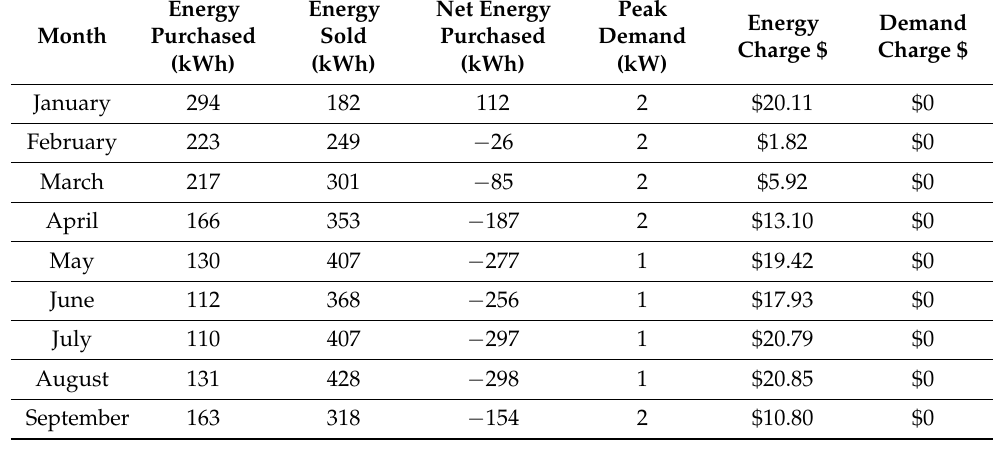
Table 22. Energy bought and sold during the year, difference and price in each month.